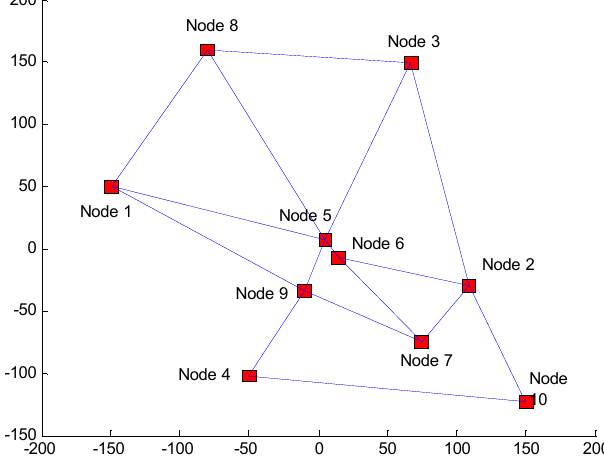
Figure 3. Graph with CONFIG 10-1 configuration (10 nodes).